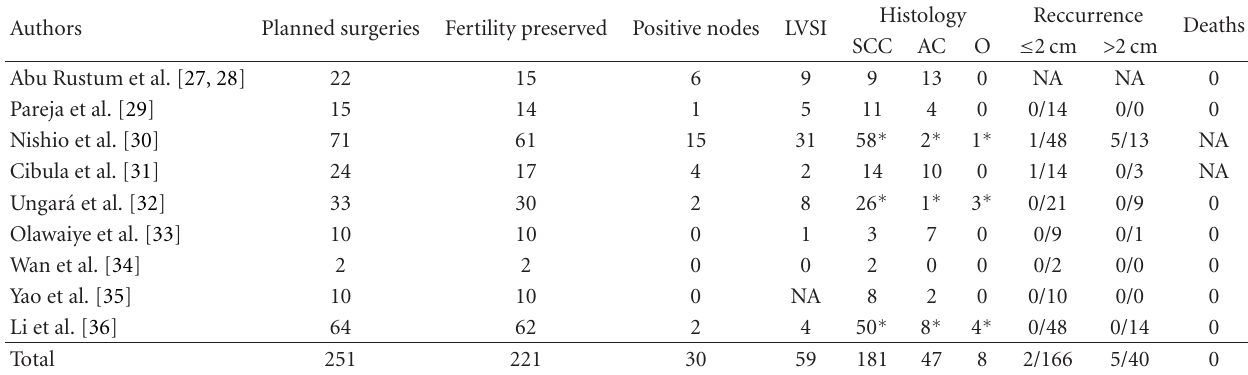
Table 4: Characteristics and oncological outcome of